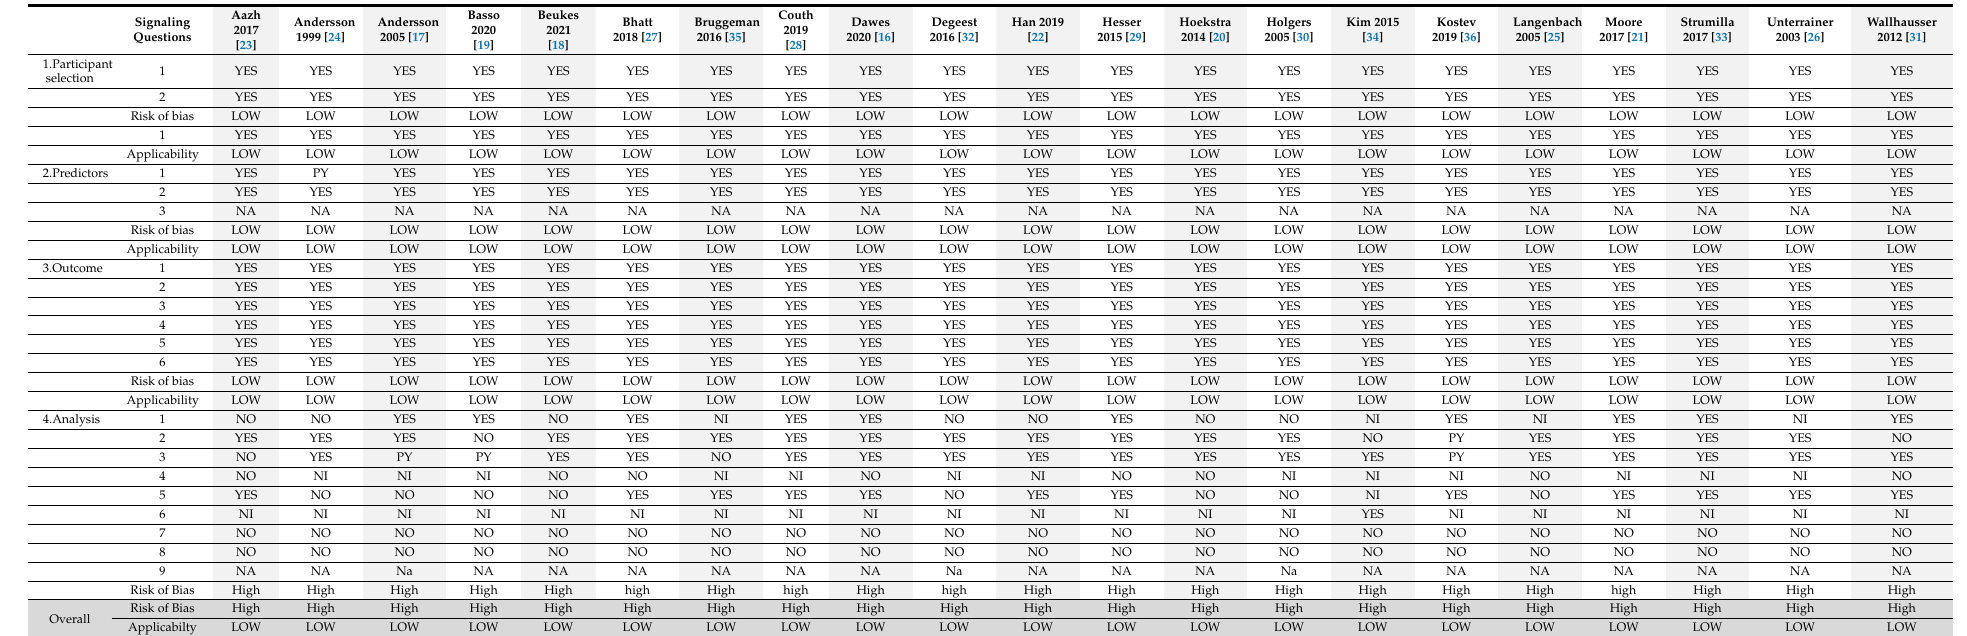
Table 2. Critical Appraisal of Topic (CAT).